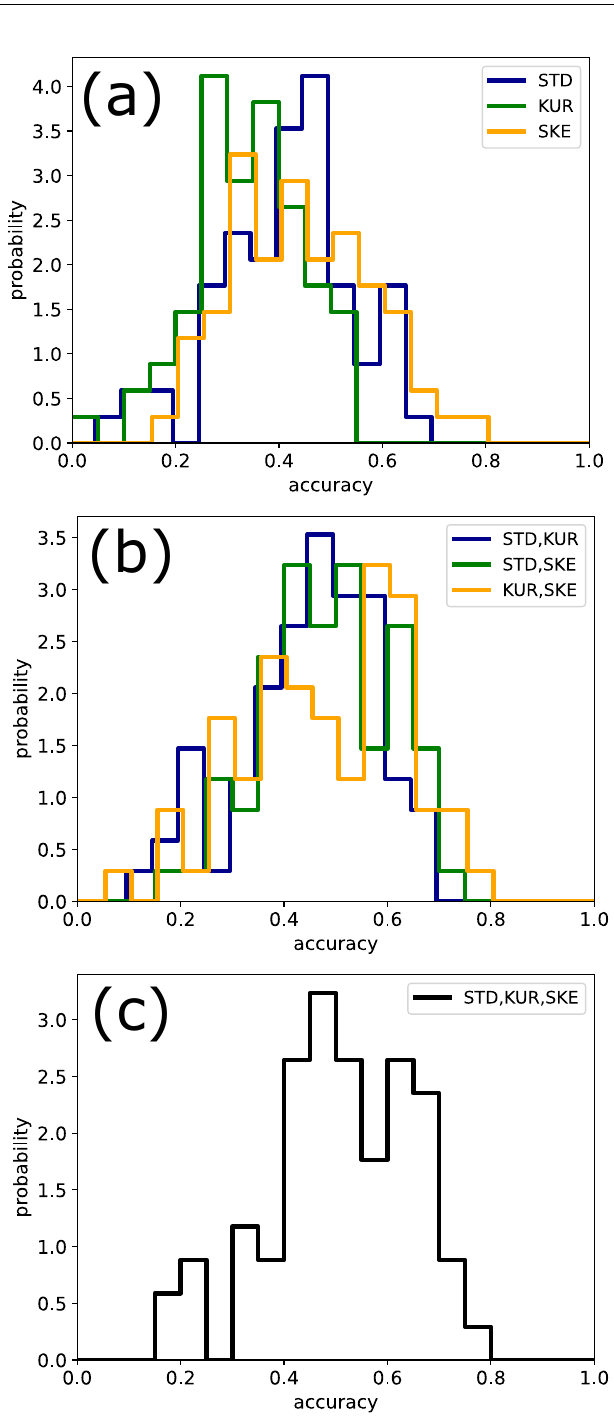
Fig. 7 Dependence of classi fi cation accuracy on the used hyper- parameter combination. Distributions of accuracies over all 68 data sets, with different combinations of hyper-parameters used in the Bayesian likelihood: a Single hyper-parameters. Here, the individual mean accuracies are μ STD = 0.42, μ KUR = 0.34, μ SKE = 0.44, and the global mean of these three values is μ glo = 0.40. b Pairs of hyper-parameters. Here, μ STD,KUR = 0.45, μ KUR,SKE = 0.47, μ STF,SKE = 0.48, and the global mean is μ glo = 0.47. c All three hyper-parameters. Here the global mean is μ glo = 0.51. The global mean is systematically increasing with the number of used